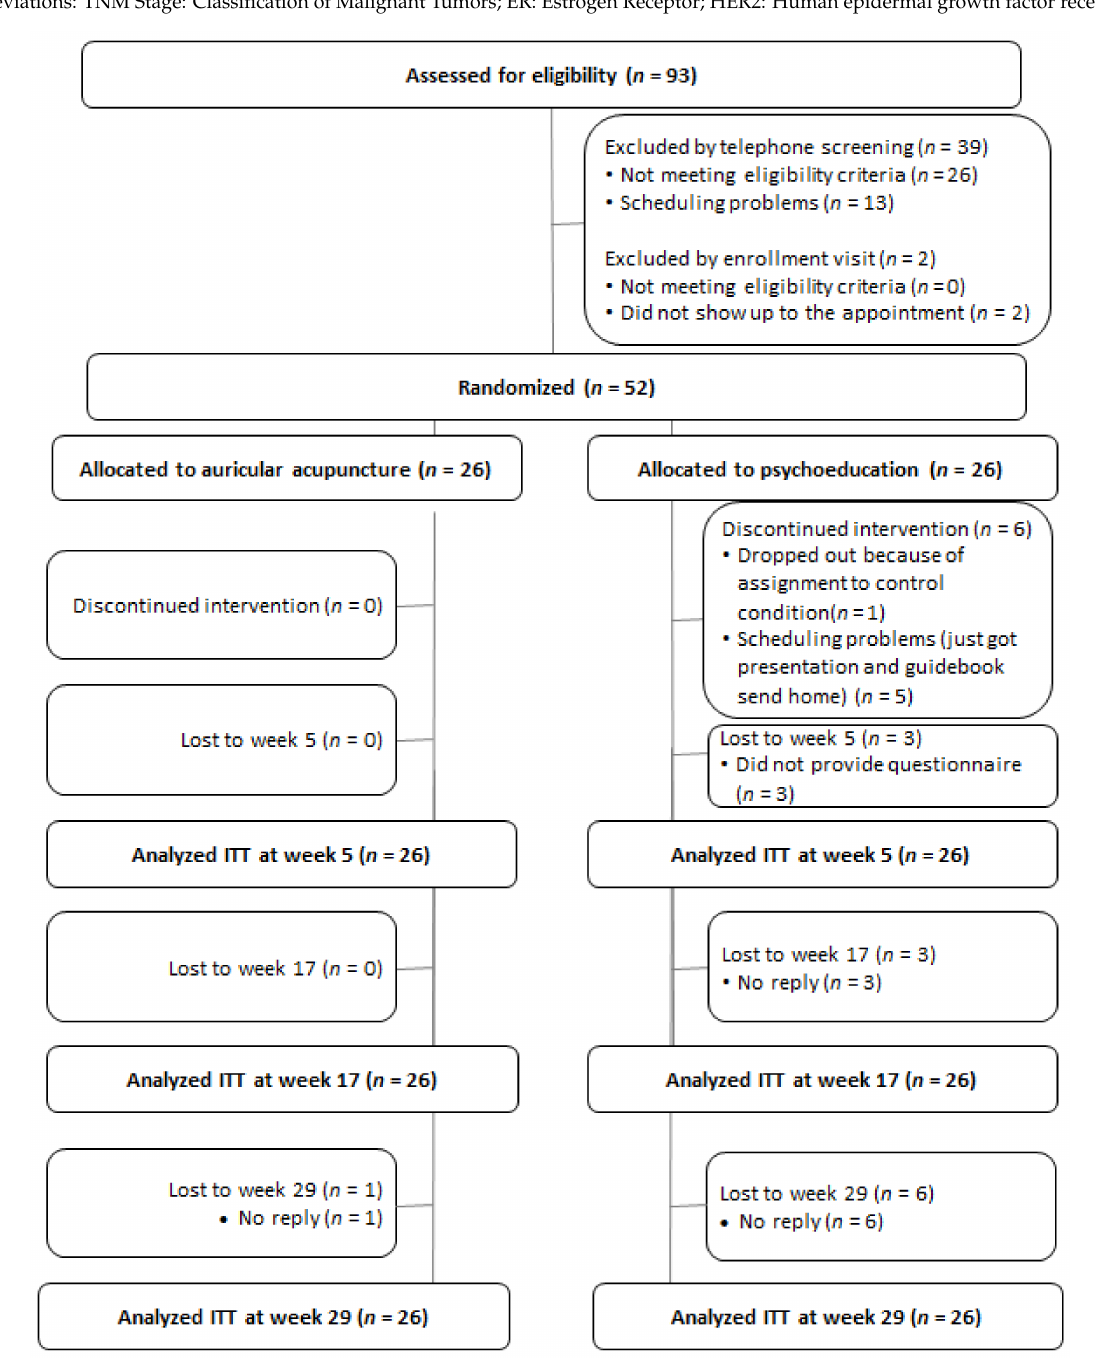
Figure 2. Study Flow. Abbreviation: ITT: intention-to-treat